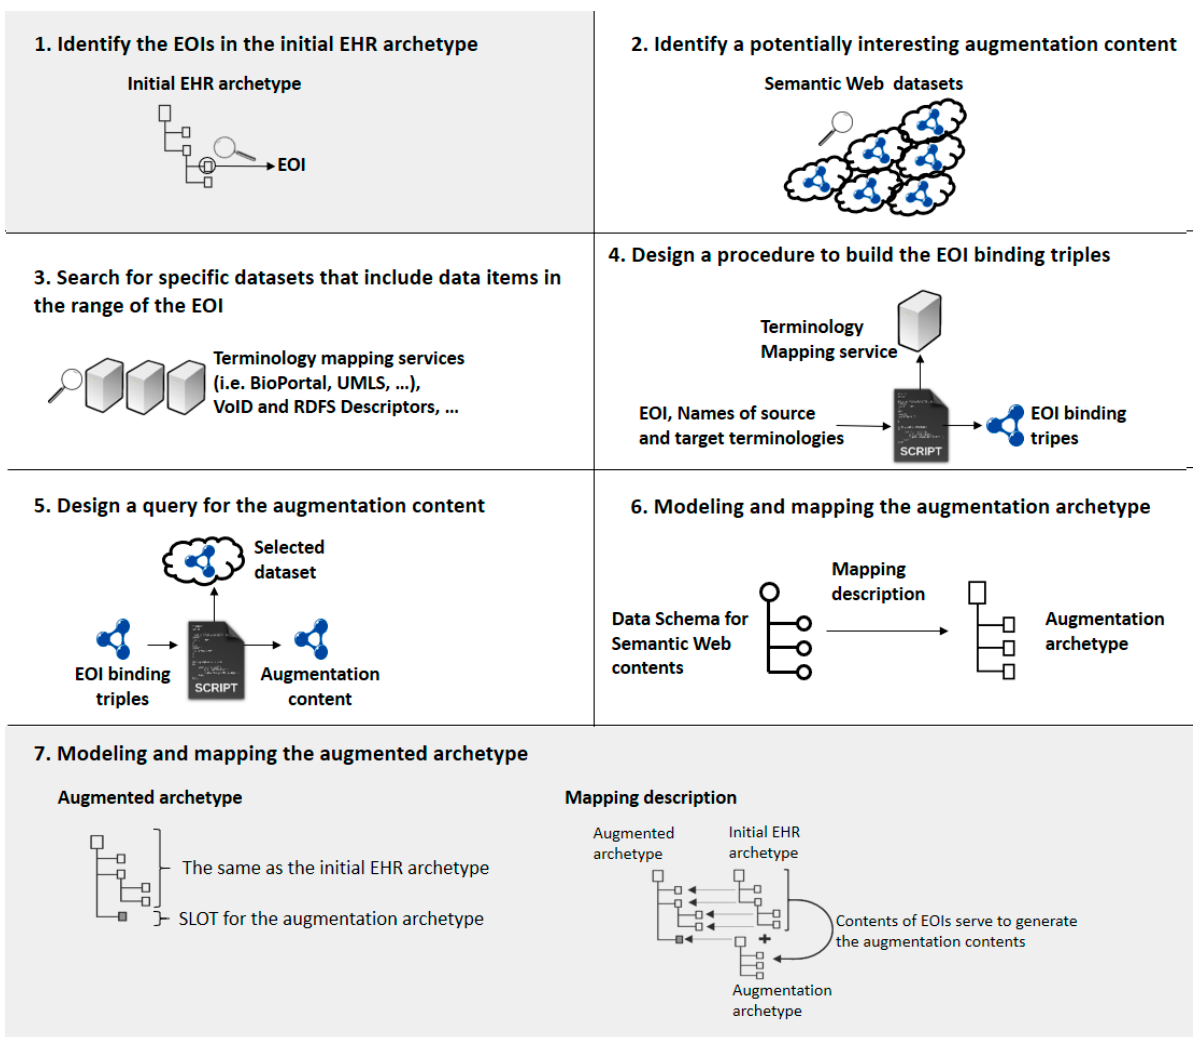
Figure 2. Methodology to define the augmentation archetype (steps 2 to 6) and the whole process to obtain the augmented archetype (steps 1 to 7).